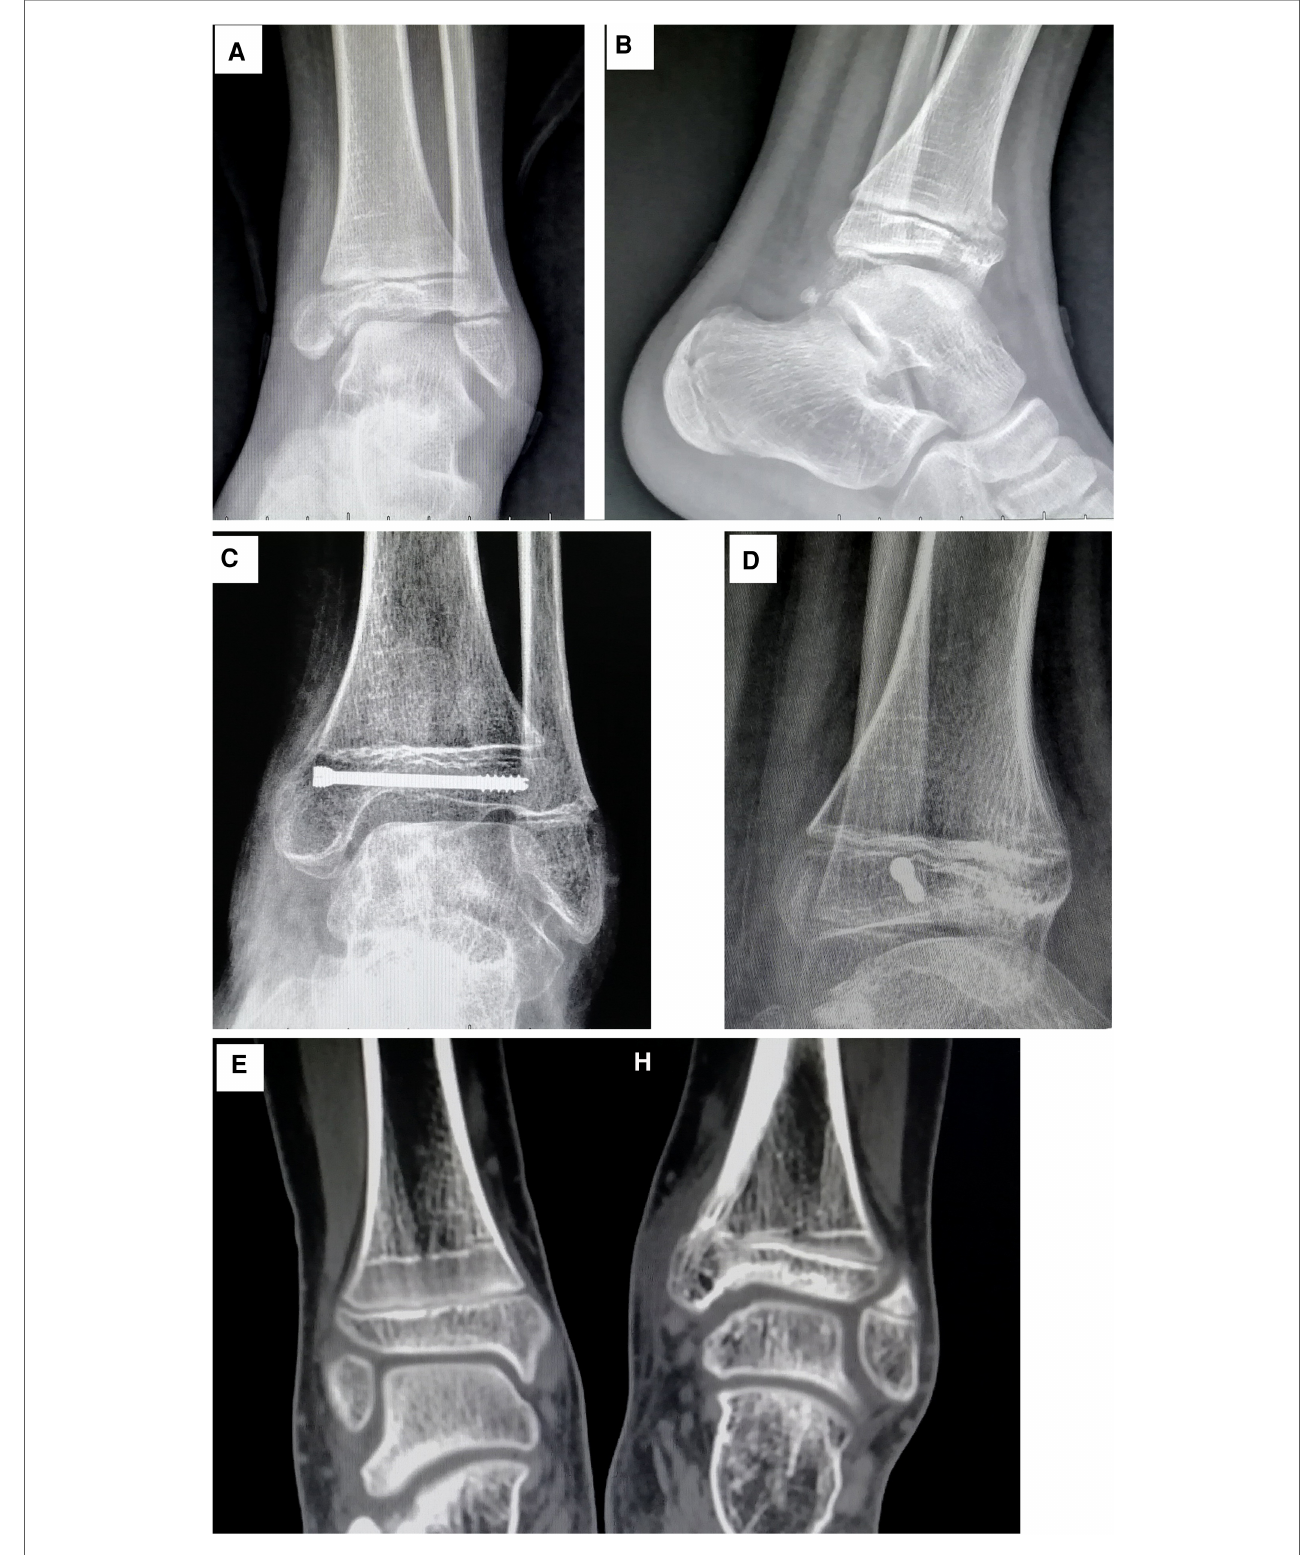
FIGURE 2 ( A ) Radiographs and CT images of a 12-year-old boy. The anteroposterior view shows a tibial epiphyseal fracture on the left side. ( B ) Lateral view showing that the fracture line crosses the epiphyseal plate (Salter – Harris type IV fracture). ( C ) Radiograph taken after 90 days of follow-up showing the growth arrest line. Formation of the medial bone bridge also can be seen. ( D ) Lateral view showing the bone bridge in the front of the epiphysis. ( E ) CT scan of bilateral ankle joints showing that the growth arrest line of the healthy side is parallel to the epiphysis, whereas the growth arrest line of the affected side forms an angle with the epiphysis. The apex of the angle is at the medial bone